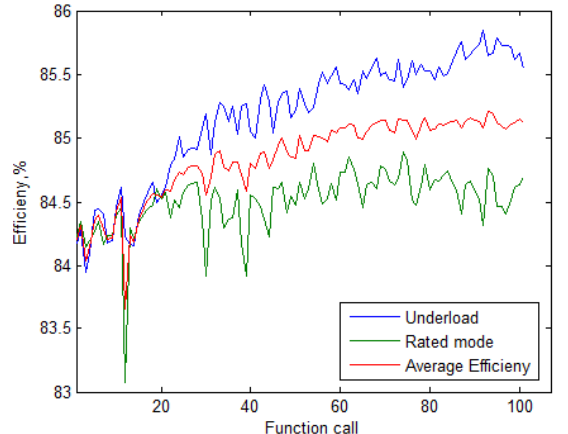
Figure 13. Change of the motor efficiency during the second optimization.